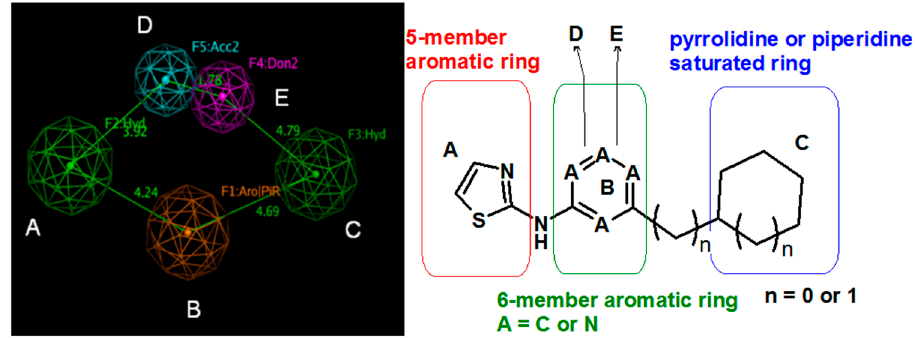
Figure 1. General pharmacophore of serine-threonine kinase inhibitors (MOE 2010.10) and results of its application to ASINEX library.